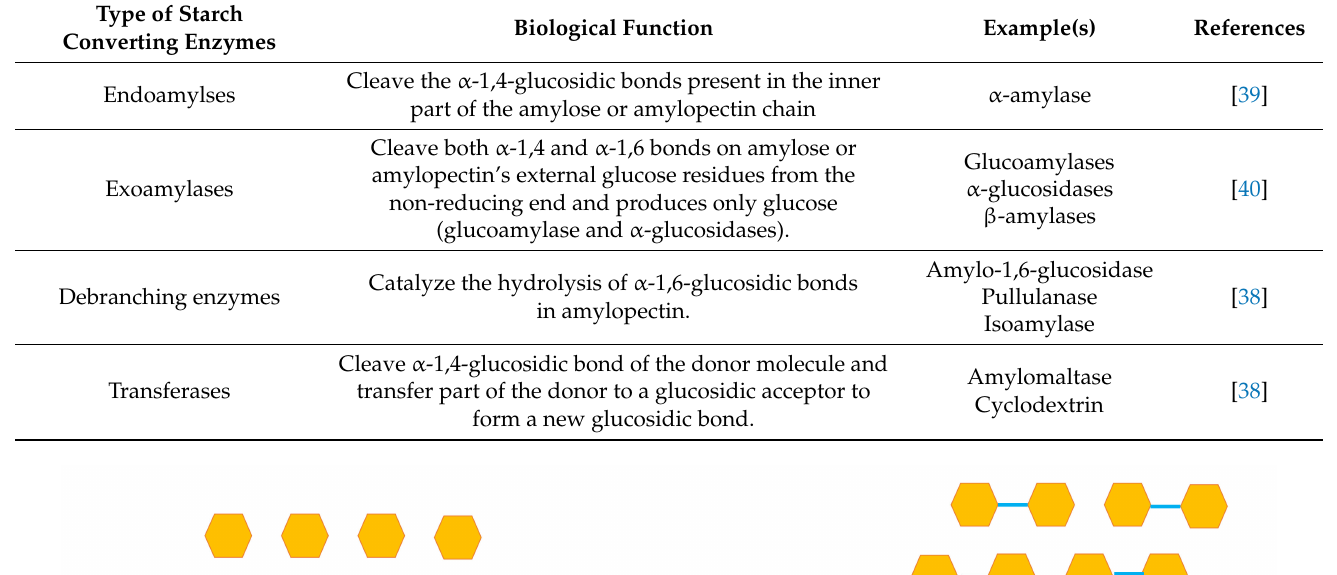
Table 1. Main types of starch converting enzymes and their biological function.